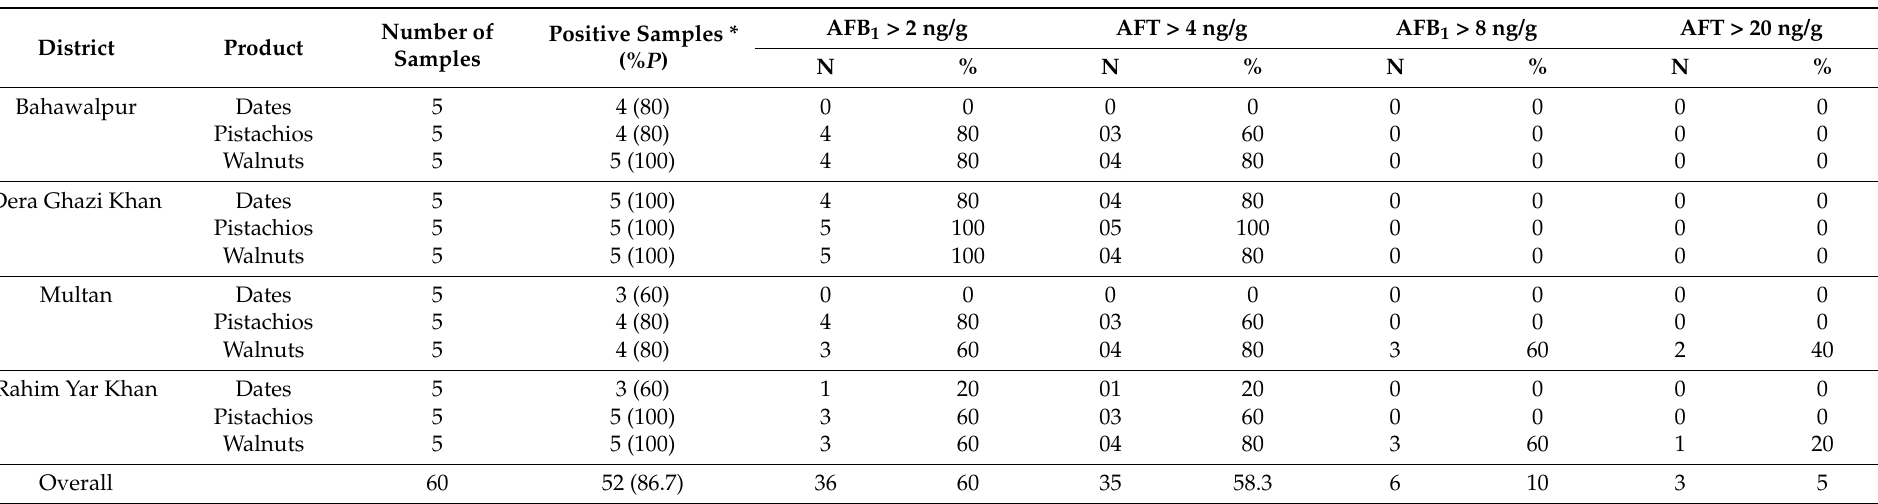
Table 4. Prevalence of AFB 1 and AFT in dates, pistachios, and walnuts and percentage of the samples exceeding the maximum tolerable limits (MTL) set by the European Union [36] and the more permissible level widely adopted in most developing countries around the